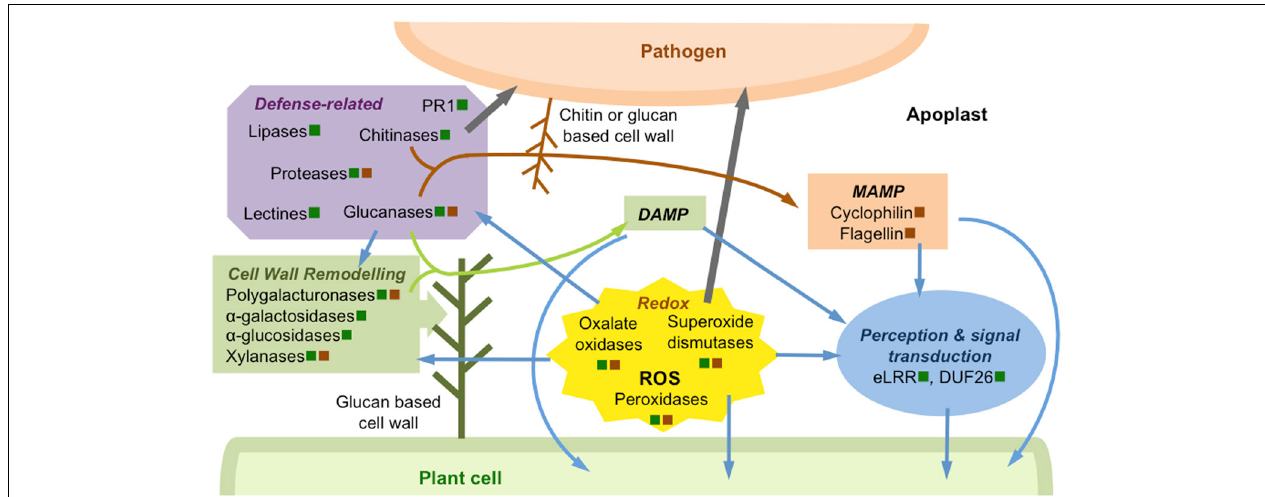
FIGURE 1 | Schematic overview of some events occurring in apoplast during plant pathogen interactions. This illustration, based on studies described in this paper, presents some examples of apoplastic proteins regulated during biotic stresses. These proteins are secreted by the plant cell (green square) and/or pathogen (brown square). Some proteins, modulated in the apoplast after DAMP or MAMP perception, are involved in pathogen perception and signal transduction, leading to the activation of intracellular plant defense signaling pathways (blue arrows). The regulation of a large amount of proteins involved in redox homeostasis modulates the ROS signaling pathway leading to activation of extra- and intracellular plant